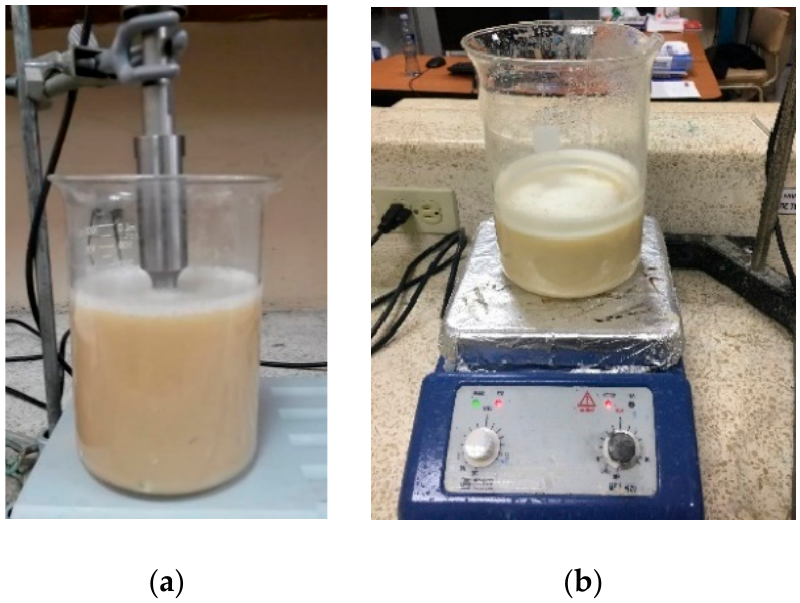
Figure 6. Preparation of nanoclay in ultrasonic processor ( a ) and magnetic stirrer ( b ).